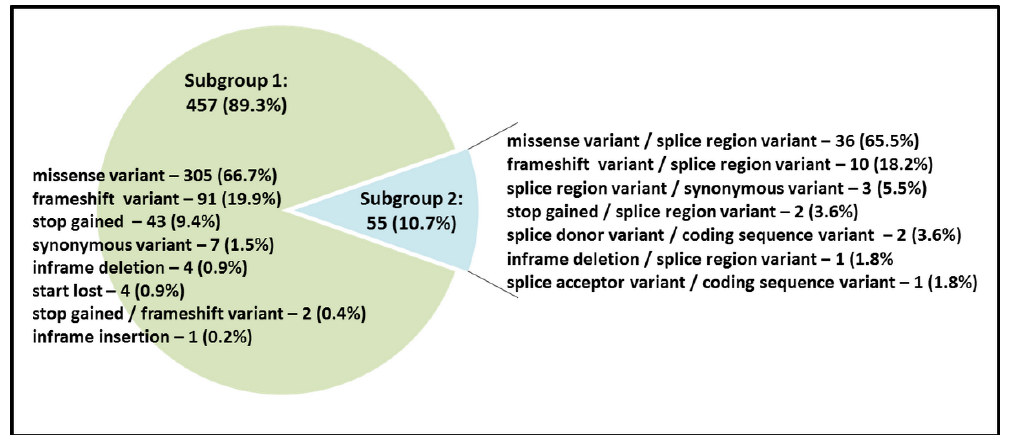
Figure 2. The distribution of PLP variants located in the SLC26A4 coding region according to their molecular consequences.